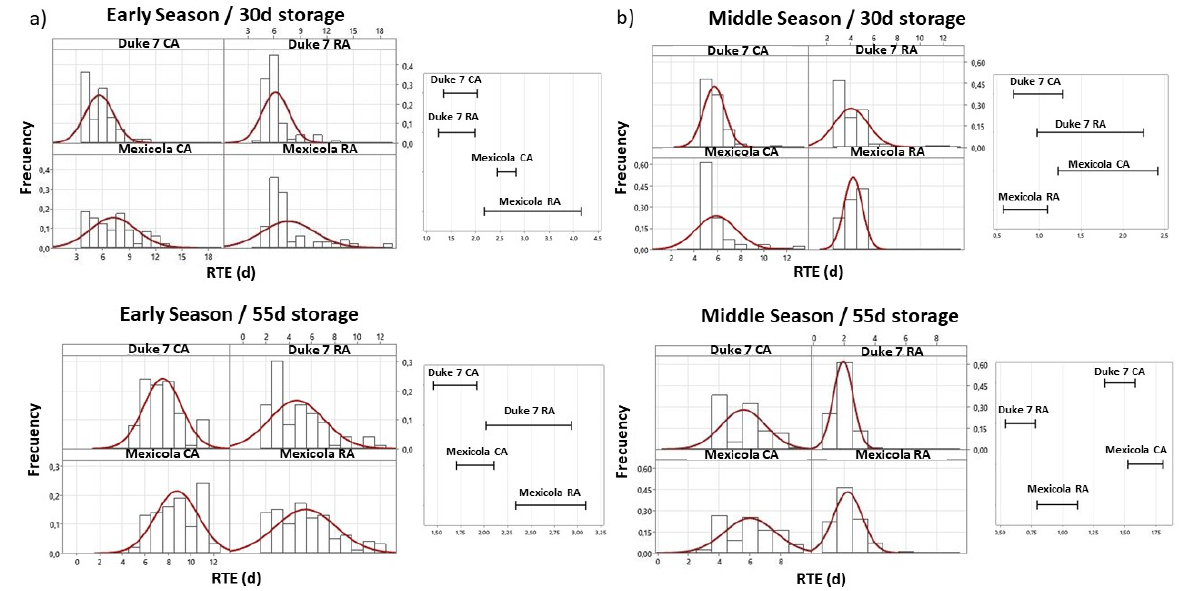
Figure 3. Evaluation of ripening heterogeneity: ( a ) early harvest fruit and ( b ) middle-harvest fruit. The treatments corresponded to: “Duke 7” and “Mexicola” rootstocks stored for 30 d and 55 d in regular air (RA, at 5 ◦ C) and controlled atmosphere (CA, 4 kPa of O 2 and 6 kPa of CO 2 at 5 ◦ C). Significant differences were evaluated at p < 0.05 using the methods of Brown and Forsythe [48] and Banga and Fox [49] and visualized as described by [50]. Histograms show the percentage of avocados reaching each RTE (ready to eat). Bars show how many avocados ripened at each RTE (d). Figures represent the confidence intervals of the standard deviation of the RTE (d).